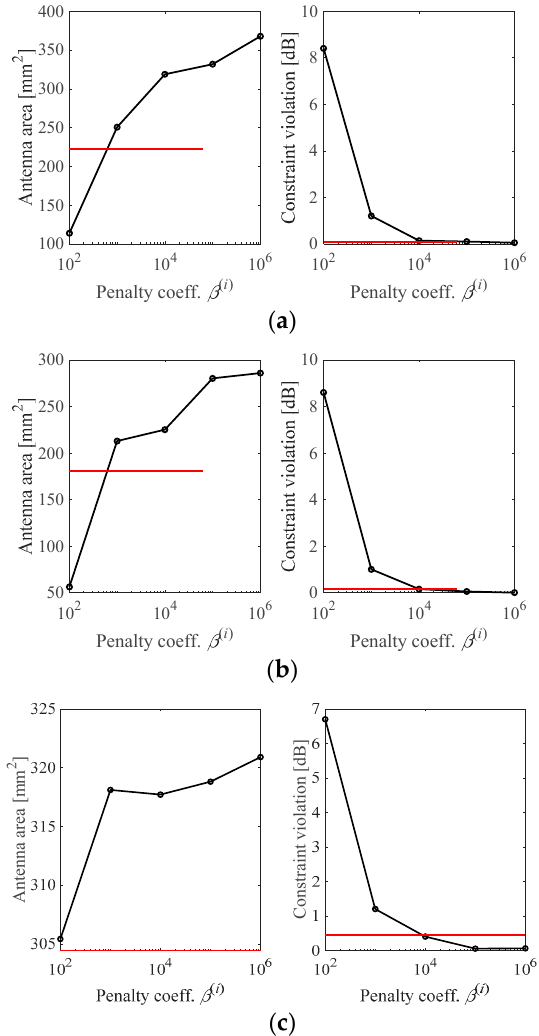
Figure 10. The average antenna footprint (left panel), and the average constraint violations (right panel) versus discrete values of the penalty coefficient utilized by the fixed-setup algorithm. The horizontal lines on the left show the average antenna footprint, whereas the ones on the right denote the average constraint violation for the designs obtained using the proposed automated adjustment algorithm. Defining the same constraint violation levels as the comparison criterion, the proposed algorithm outperforms the fixed-setup algorithm in terms of the achievable miniaturization rates, even under the optimistic scenario of having set beforehand the optimum value of β for the